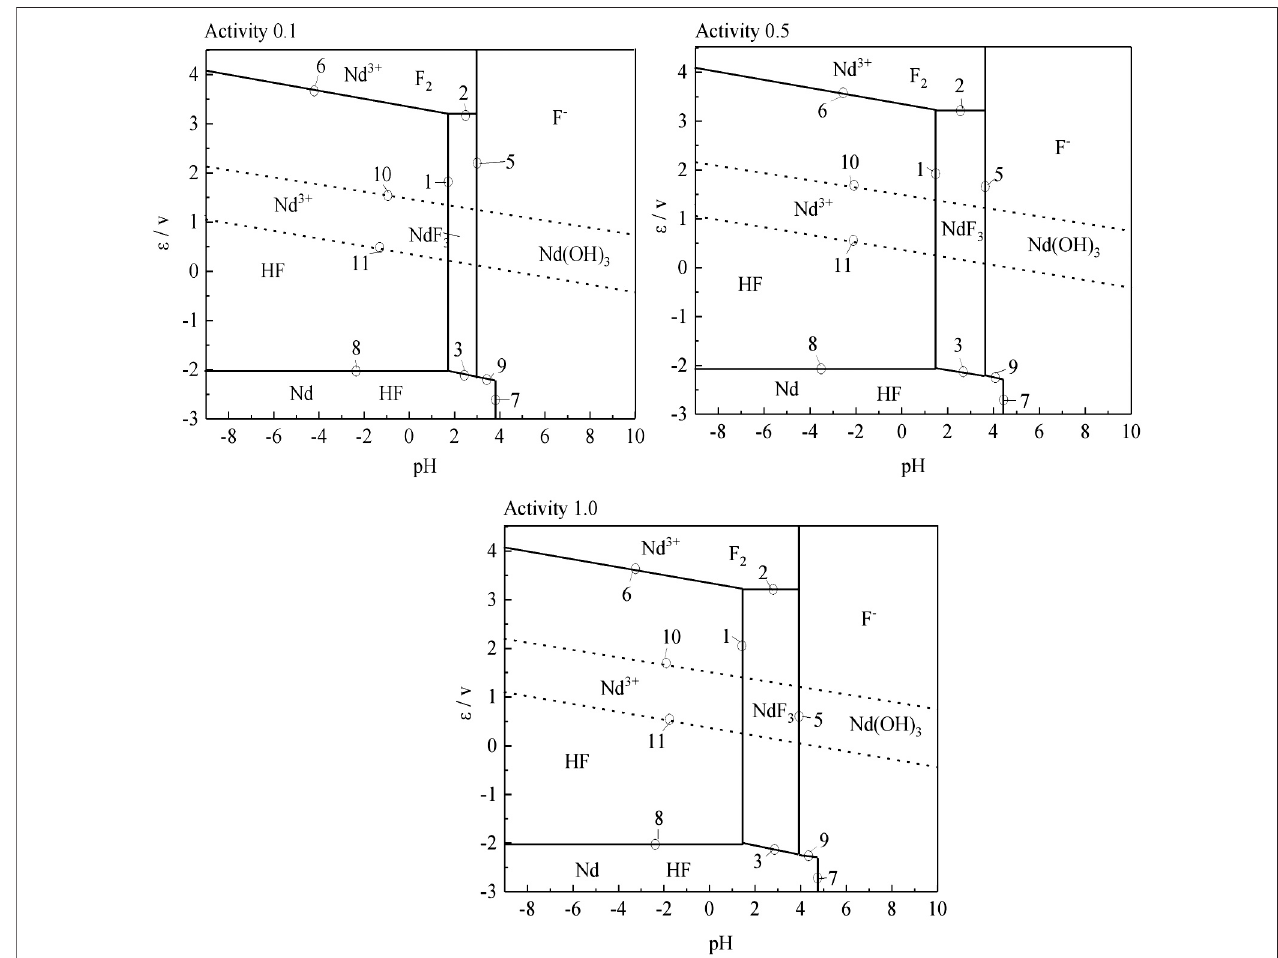
FIGURE 6 | ε -pH diagram of the Nd-F-H 2 O system with different activities at 633 K.